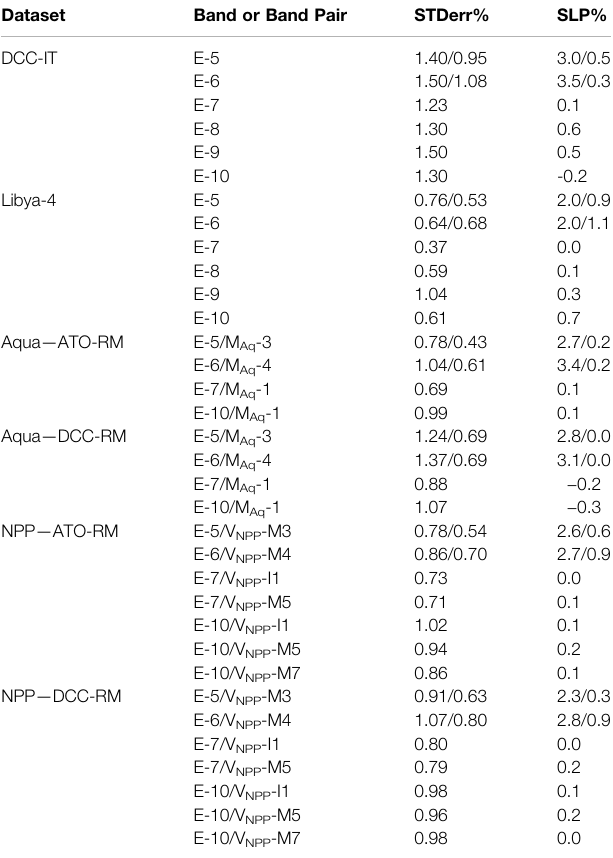
TABLE 5 | The monthly gain linear regression standard error ( STDerr% ) and slope (%overthe6-yearsrecord)forallinvarianttargetsandbandpairs.TheE-5and E-6 band linear regression statistics are performed twice (2015 – 2017 and 2018 – 2021, separated by a “ / ” ).